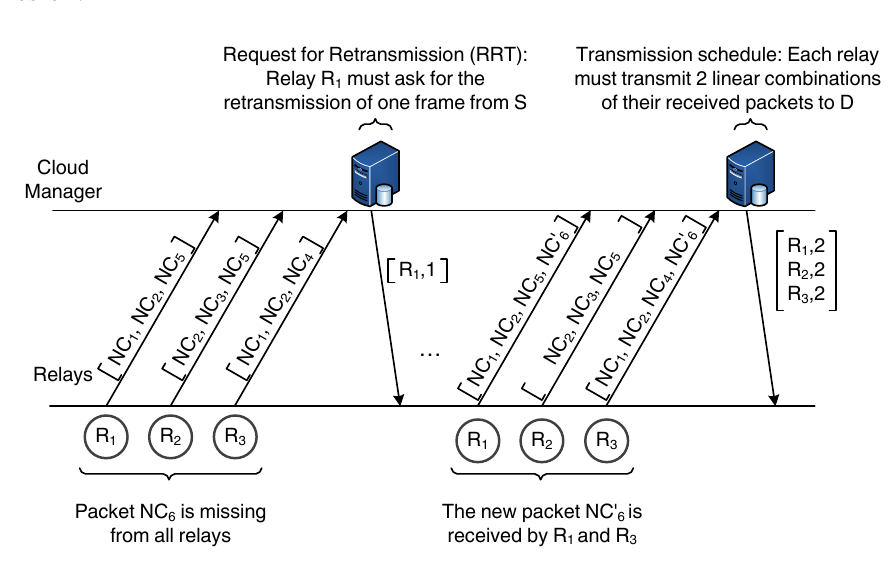
Figure 6. Information exchange between the relays and the cloud manager. RRT, request for retransmission.